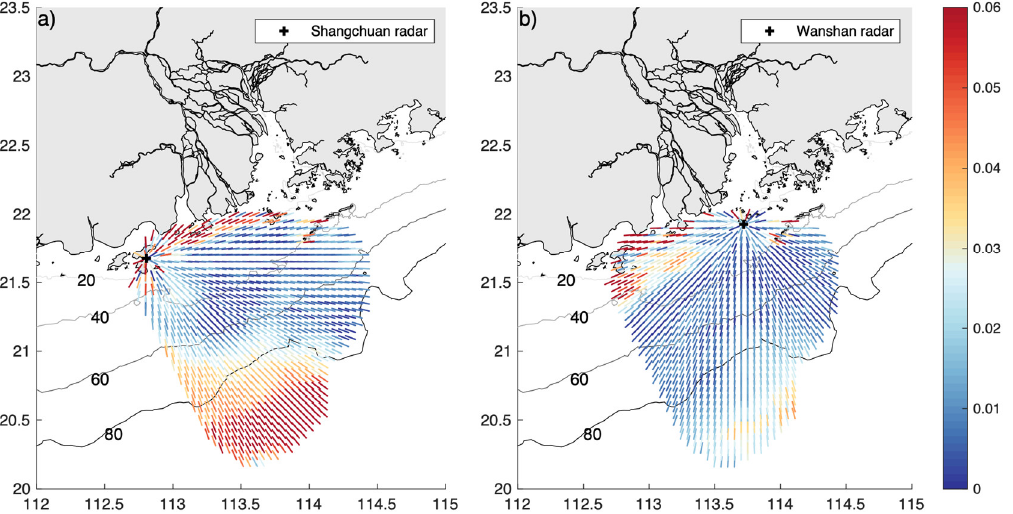
Figure 8. Radial error distribution of the M 2 ellipse amplitude (cm/s, shaded) attributed to ( a ) the Shangchuan radar station and ( b ) the Wanshan radar station. Isobaths (m) are marked with color- changing solid lines.